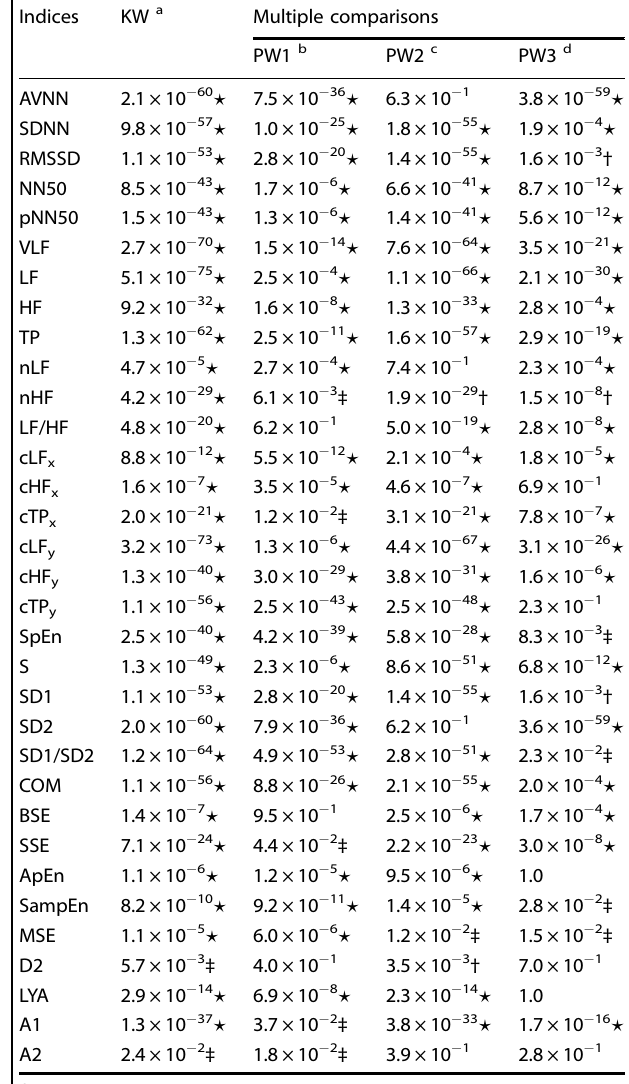
Table 4. Kruskal – Wallis and post hoc multiple comparisons p values for the comparison among blood pressure states from indices measured from pulse rate variability. ‡ : p value less than 5.00 × 10 − 2 ; †